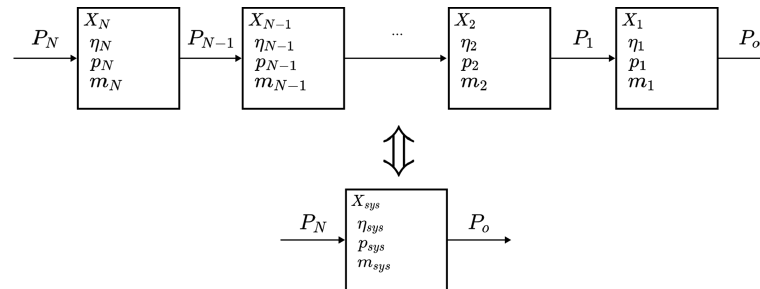
Figure 4. Series connection.